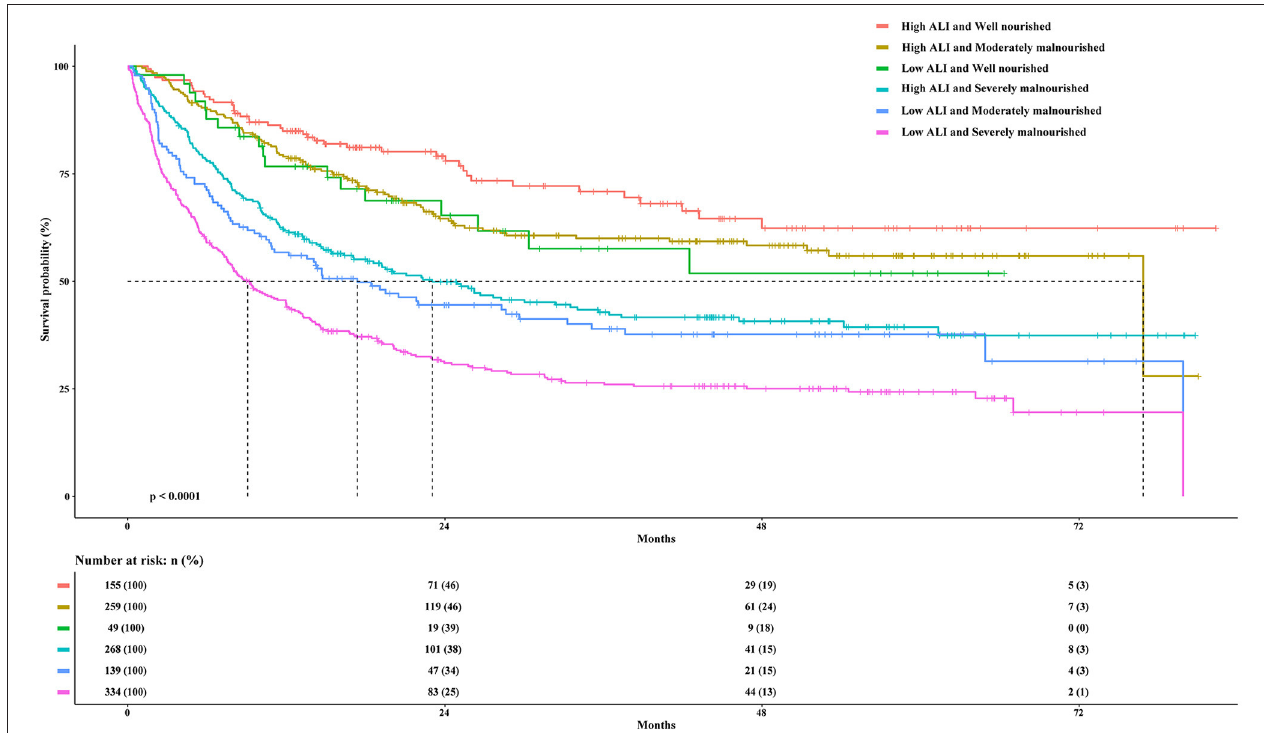
FIGURE 4 | The Kaplan-Meier survival curves of the ALI combined with the PGSGA for the OS of patients with sarcopenia. ALI, Advanced Lung Cancer Inflammation Index; PGSGA, Patient-Generated Subjective Global Assessment; OS, overall